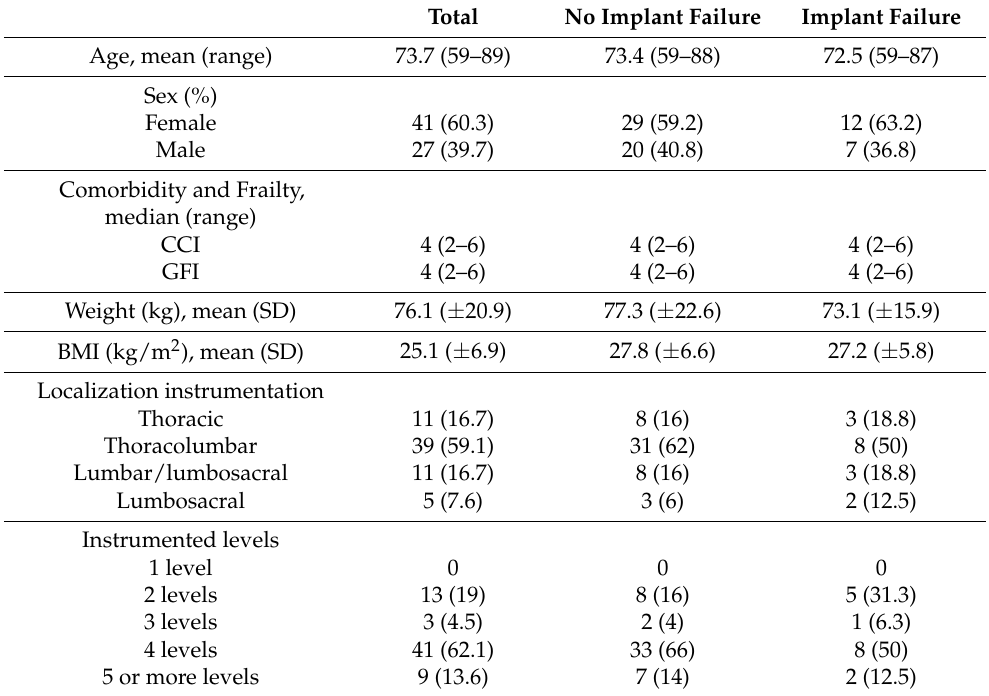
Table 1. Baseline demographics. Charlson Comorbidity Index (CCI), Groningen Frailty Index (GFI), and body mass index (BMI).